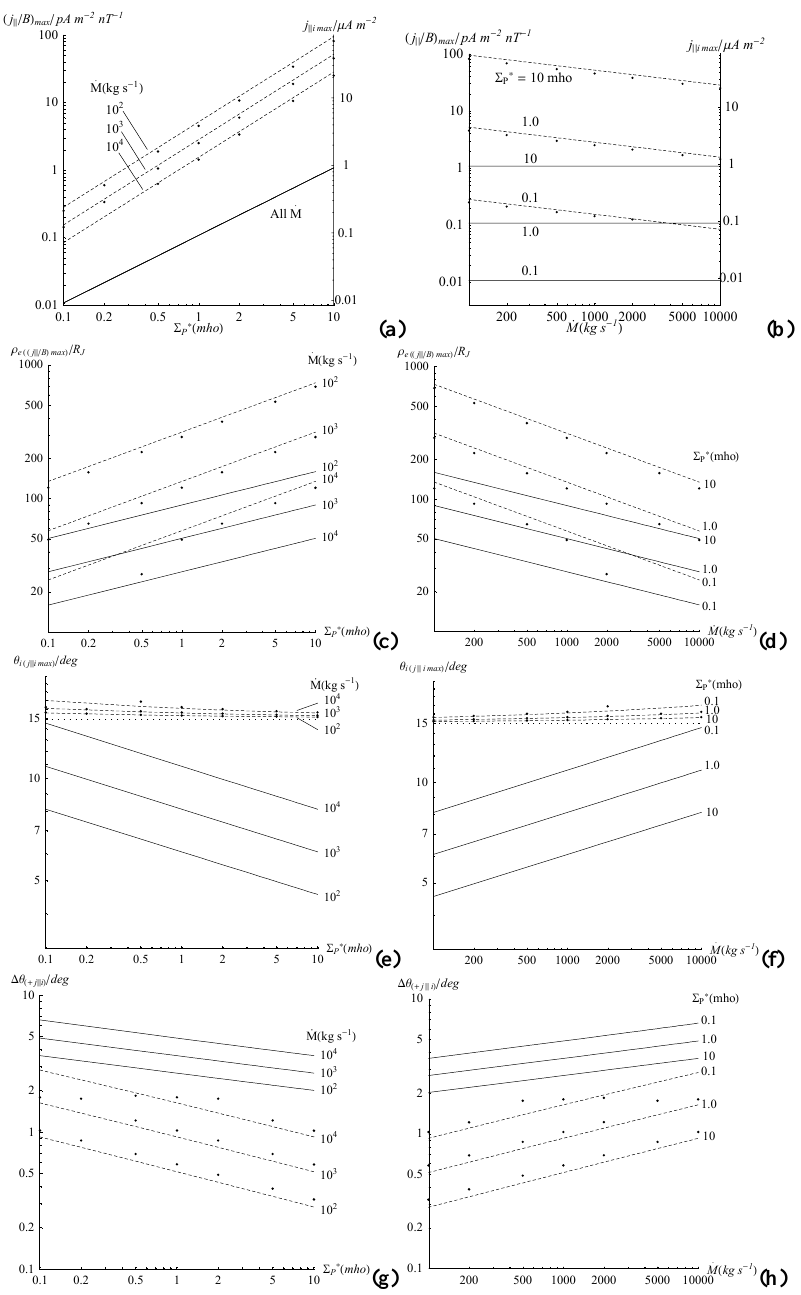
Fig. 12. Plots showing the magnitude, location and half-width of the peak upward-directed field-aligned current density, and their dependence on 6 ∗ and ˙ M . Plot (a) shows the magnitude of the peak total current density versus 6 ∗ in log-log format for ˙ M = 100, 1000 and P P 10000kgs − 1 , where the left-hand scale shows the peak current density in the ionosphere, while the right-hand scale shows the peak (j k /B) value, simply related to the latter via Eq. (5b). Solid lines give results for the dipole field obtained from Eqs. (21e ,f), while the dashed lines show corresponding results derived from the approximate solutions for the power law current sheet model given by Eqs. (34e, f). The solid dots show spot values obtained from numerical integration of the full current sheet solution. Plot (c) shows the corresponding location of the peak (j k /B) in the equatorial plane in a similar format, while plot (e) shows the conjugate location of the peak field-aligned current in the ionosphere. Plots (b) , (d) , and (f) similarly show the magnitude and equatorial and ionospheric locations of the peak current density versus ˙ M for 6 ∗ = 0 . 1, 1 and 10mho. Plots (g) and (h) show the latitudinal width of the upward field-aligned current region in the ionosphere in P a similar format, defined as the full width at half